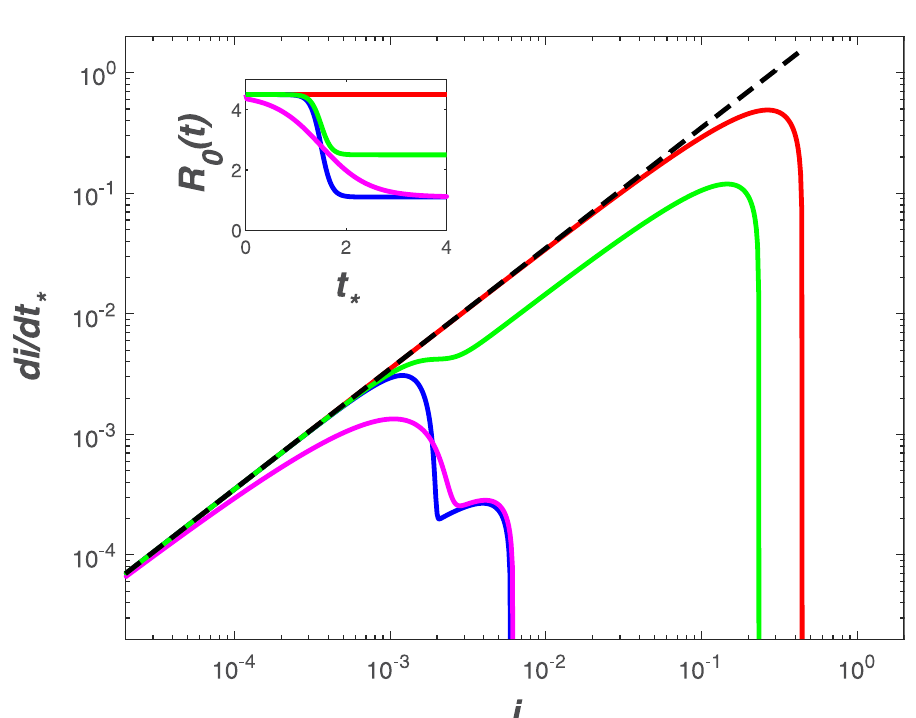
Fig 6. Modeled di / dt � as a function of i when considering a dynamic R o , d . Five scenarios are illustrated (inset): no = 4.5 set to its uncontrolled value, R = 1.1 (epidemic near containment) and k intervention (red) with R o o , c (blue), R o , c = 1.1 and k c = 0.15 (magenta), R o , c = 2.5 (typical of countries with strong initial intervention) and k c = 0.7 (green). The other parameters of the logistic functions are R o , u = 4.5 and t 50 = 1.5/ γ .